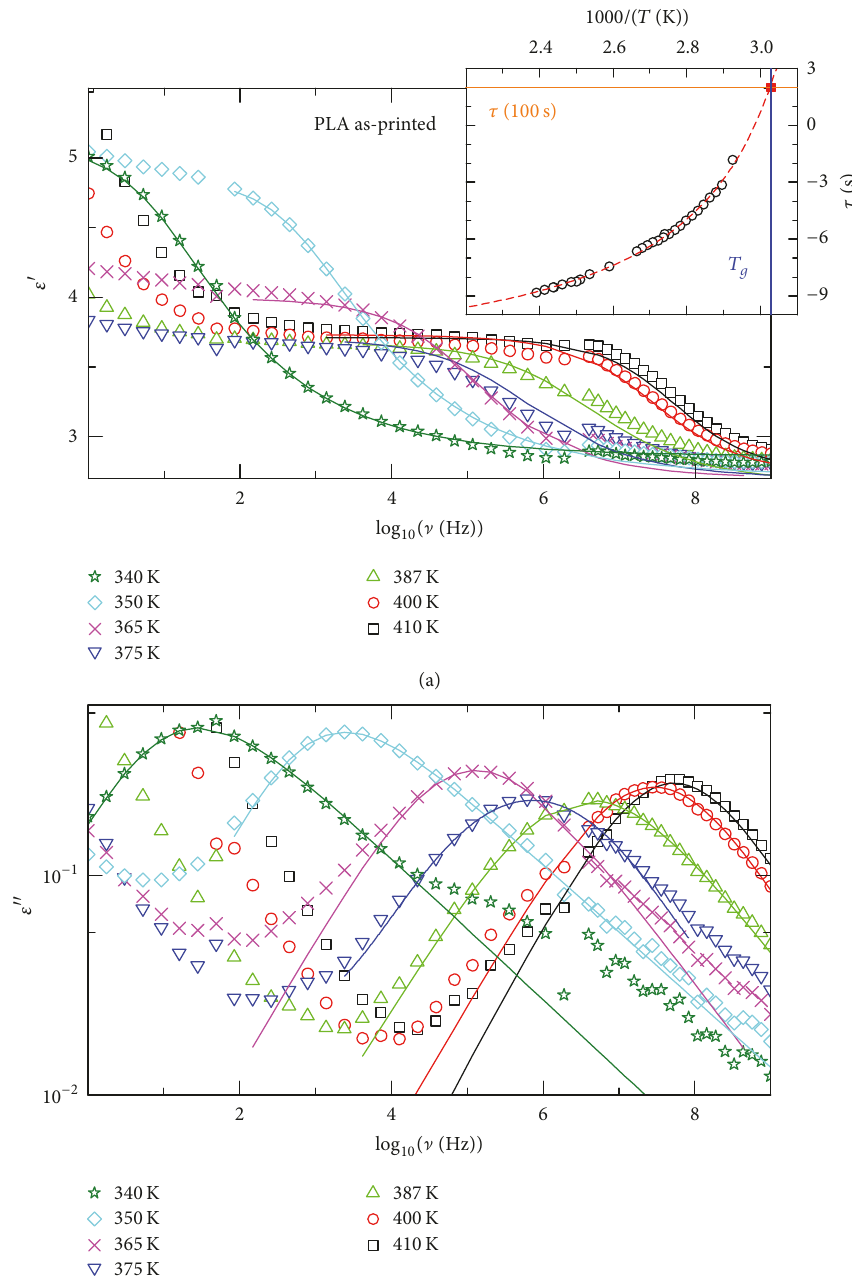
Figure 3: Dielectric constant 𝜀 󸀠 (a) and dielectric loss 𝜀 󸀠󸀠 (b) of PLA in the as-printed condition; measurements are shown as functions of frequency for temperatures ranging from 340 K to 410K. Lines are fits according to Havriliak-Negami (HN) model. The inset shows the relaxations times according to the peak maxima of the dielectric loss in an Arrhenius representation fitted with a VFT function (dashed line). The glass transition temperature is indicated at 𝜏